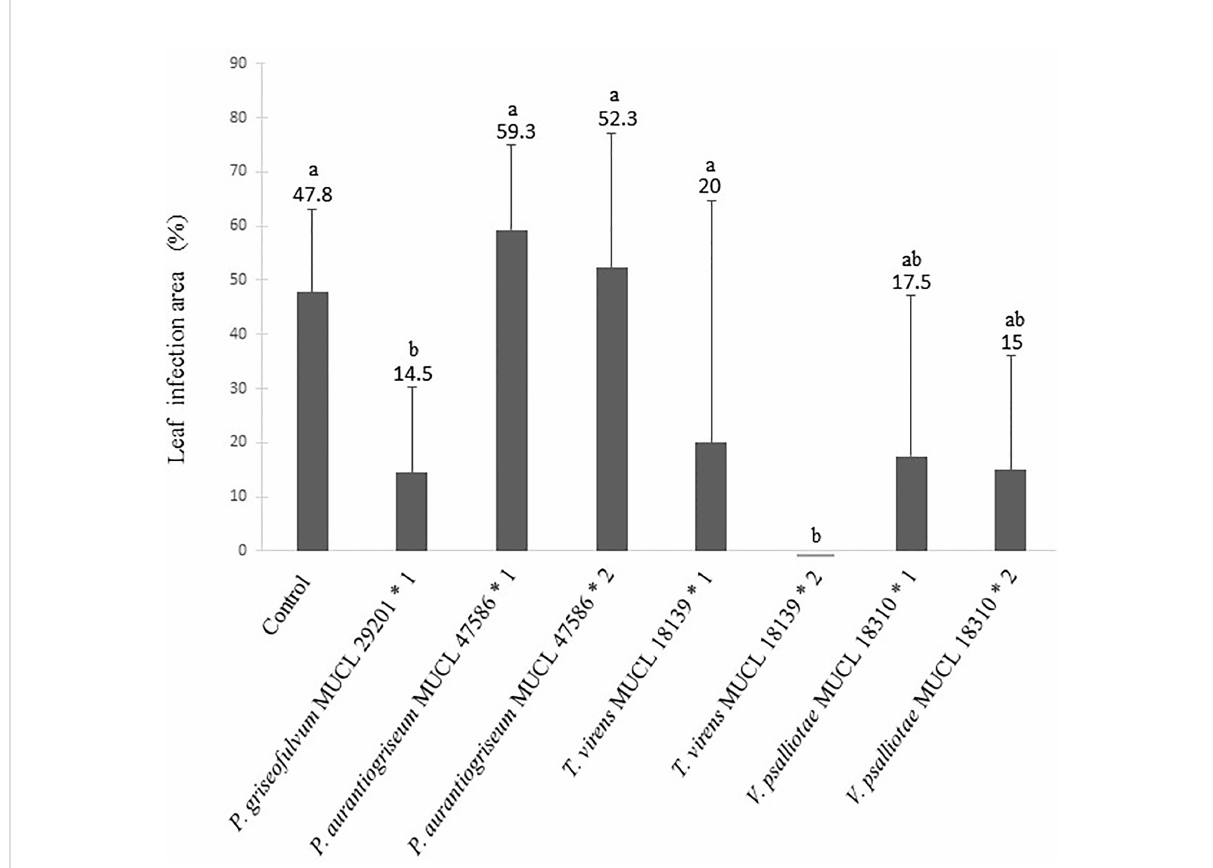
FIGURE 4 Percentage of leaf infection area (%LA) of potato plants treated or not with culture fi ltrates of fungal BCA candidates applied 1 day prior (* 1) or 1 day after (* 2) inoculation with P. infestans MUCL 54981. Values are expressed as the mean +SD ( n = 5). Different lowercase letters show signi fi cant difference between the treatments ( p ≤ 0.05; Tukey